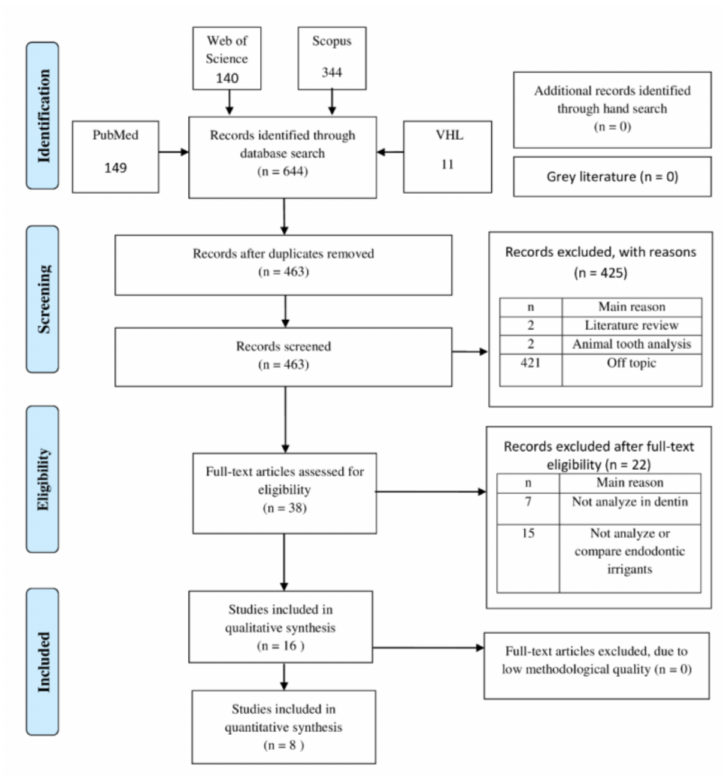
Figure 1. PRISMA flow